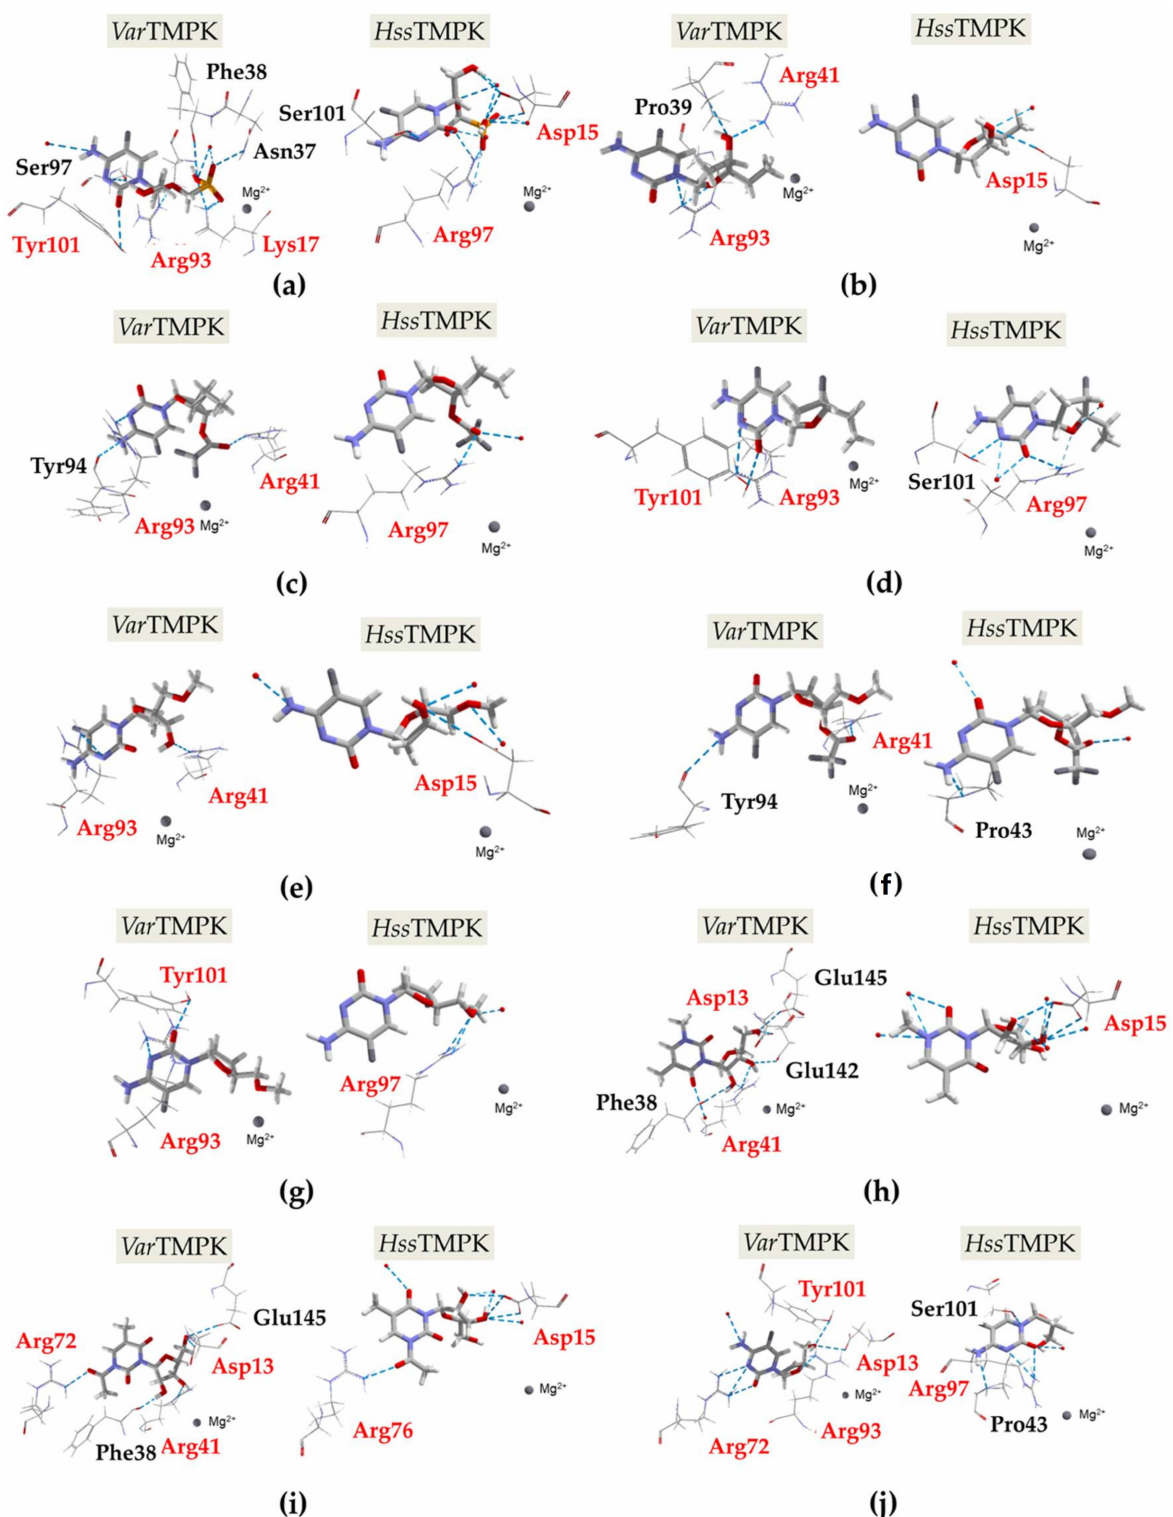
Figure 3. Interactions observed for the best poses obtained inside the Var TMPK and Hss TMPK active sites: ( a ) Compound 1 , ( b ) compound 2 , ( c ) compound 3 , ( d ) compound 4 , ( e ) compound 5 , ( f ) compound 6 , ( g ) compound 7 , ( h ) compound 8 , ( i ) compound 9 , ( j ) compound 10